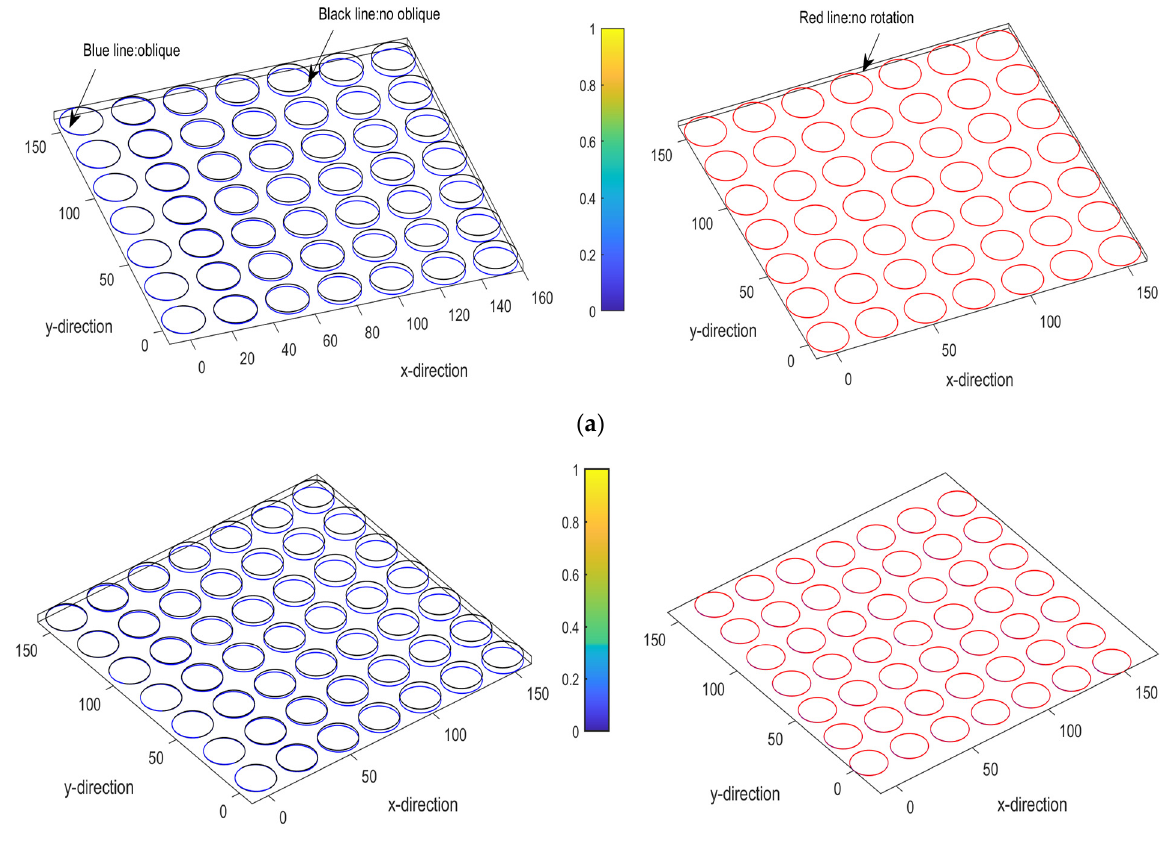
Figure 18. Dynamic NPR-embossing replication of 7 × 7 arrayed micro-column structures were simulated and predicted by MATLAB: ( a ) an inclination angle of 1 degree in uniaxial unstable stretching and ( b ) embossing replication prediction of an inclination angle of 1 degree and a rotation angle of 5 degrees in multi-directional dynamic stretching.